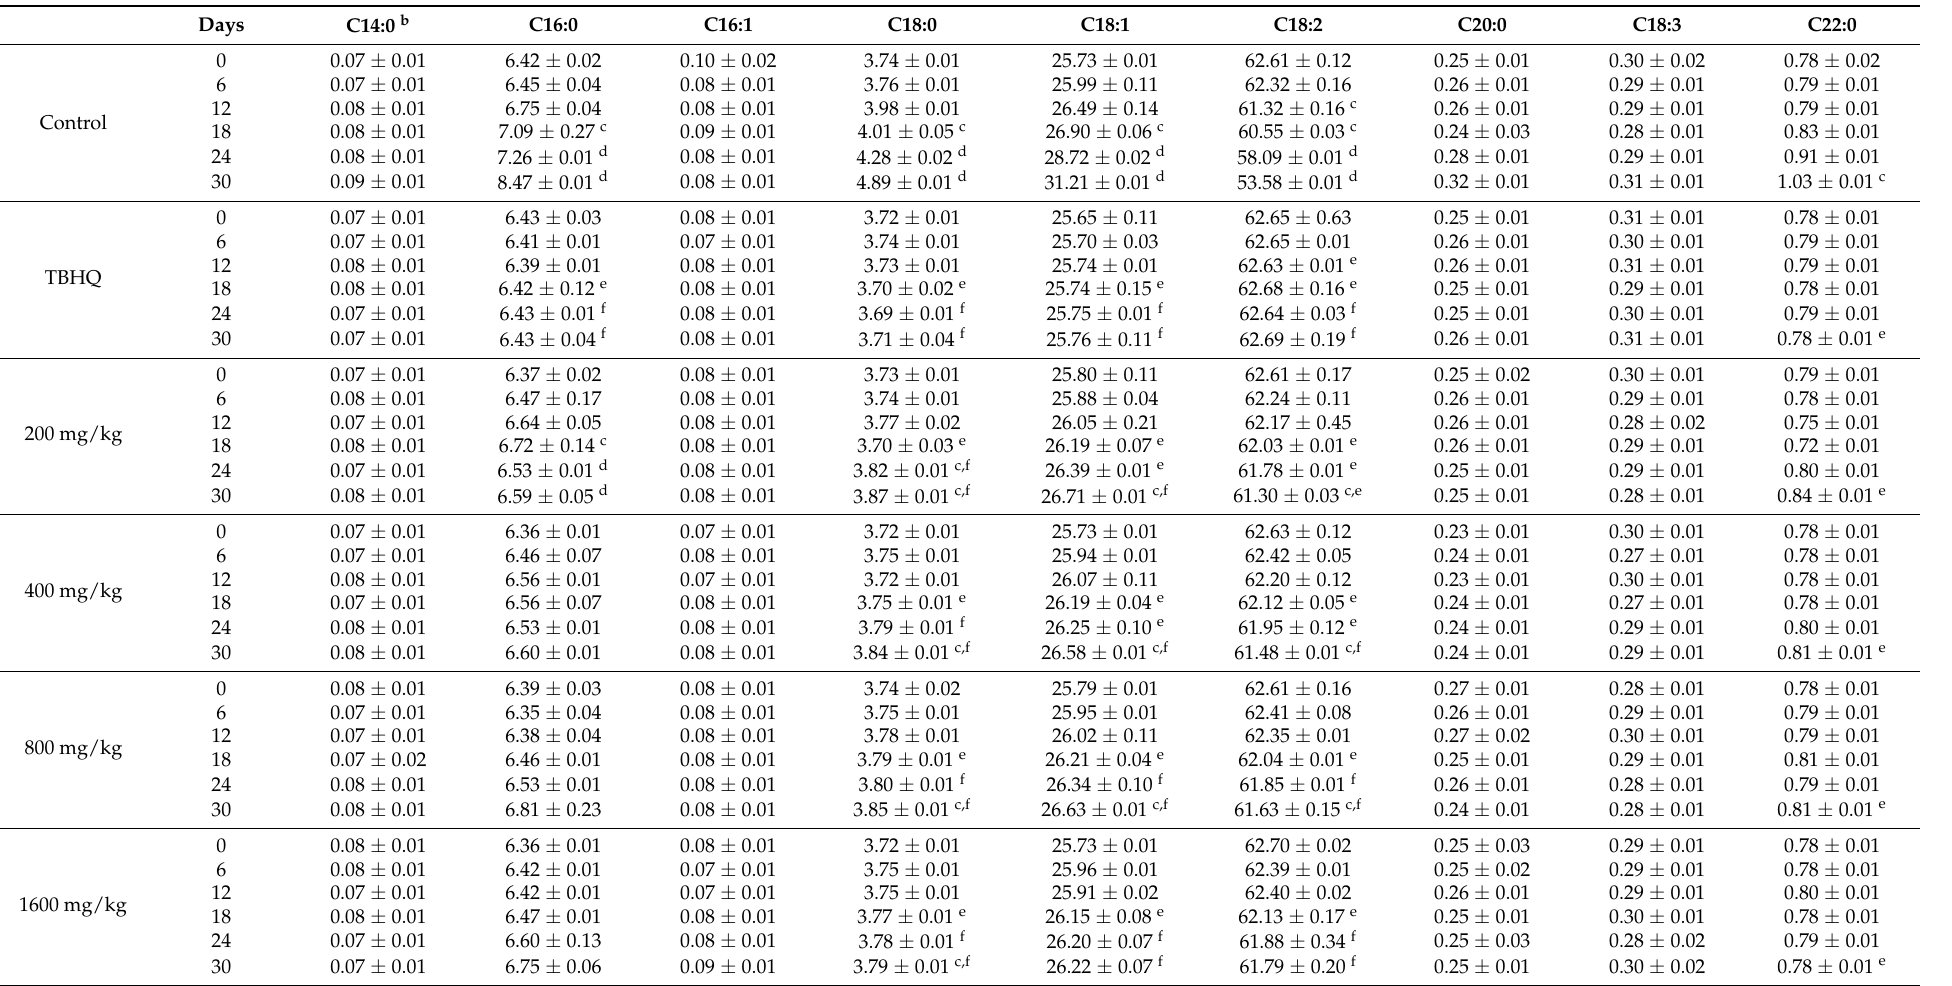
Table 3. The influence of HCEO on the fatty acid composition of the sunflower oil samples at 65 ◦ C for 30 days a